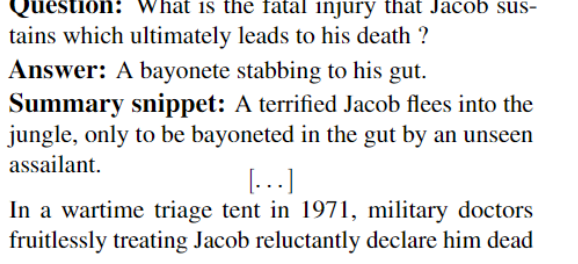
Figure 4. Free-answer MRC